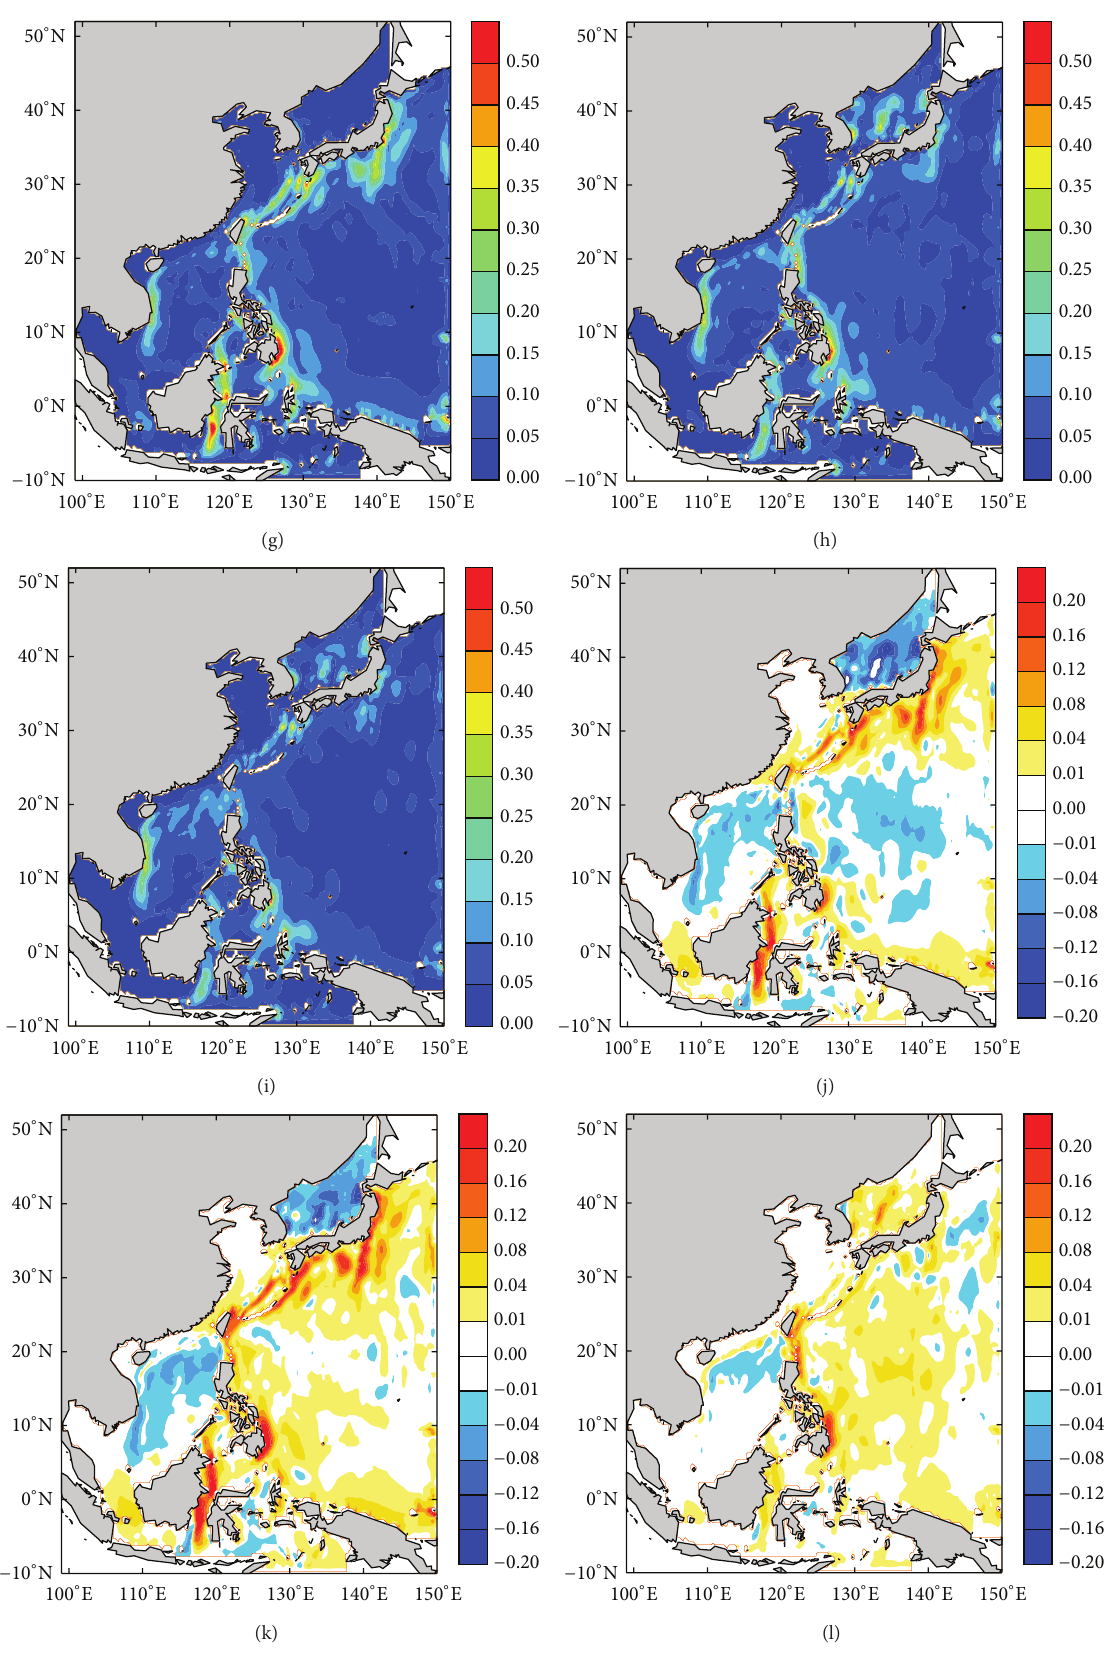
Figure 6: (a)–(f) are similar to Figure 3 but for U component and (g)–(l) are similar to Figure 3 but for V component. Unit: